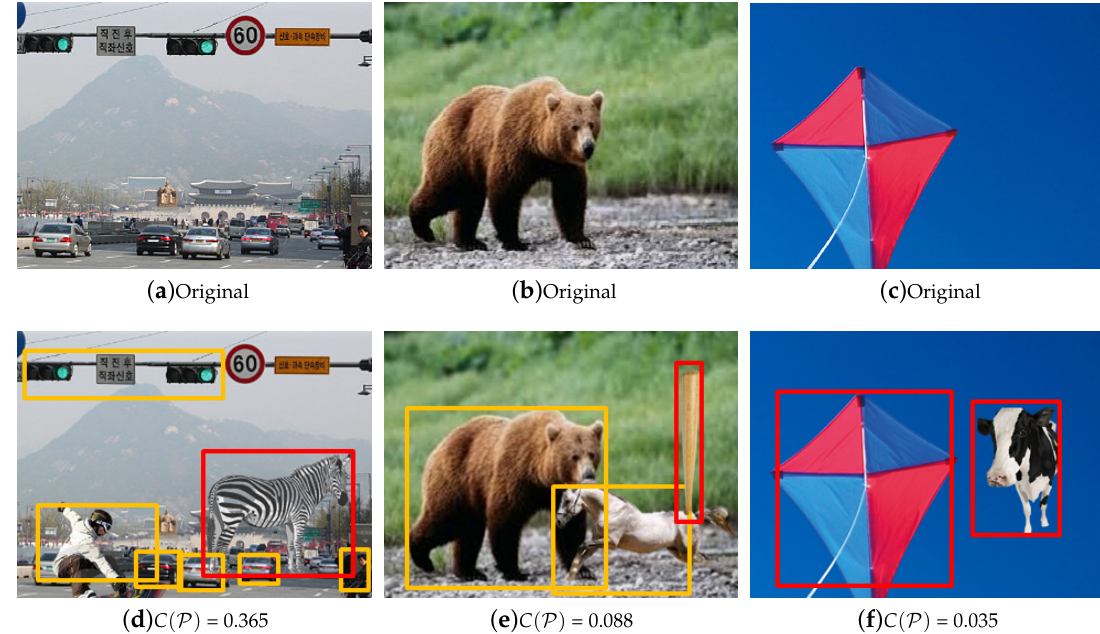
Figure 12. CL-CNN and forgery detection results with manipulated images. The object in the red box was detected as a manipulated object. The first row shows original images. The second row shows the detection results by the proposed method. ( a ) car road and a traffic light, ( b ) a bear, ( c ) a kite, ( d ) detection result of manipulated image with car road and a zebra, ( e ) manipulated image with a horse and a bat, ( f ) manipulated image with a cow in the